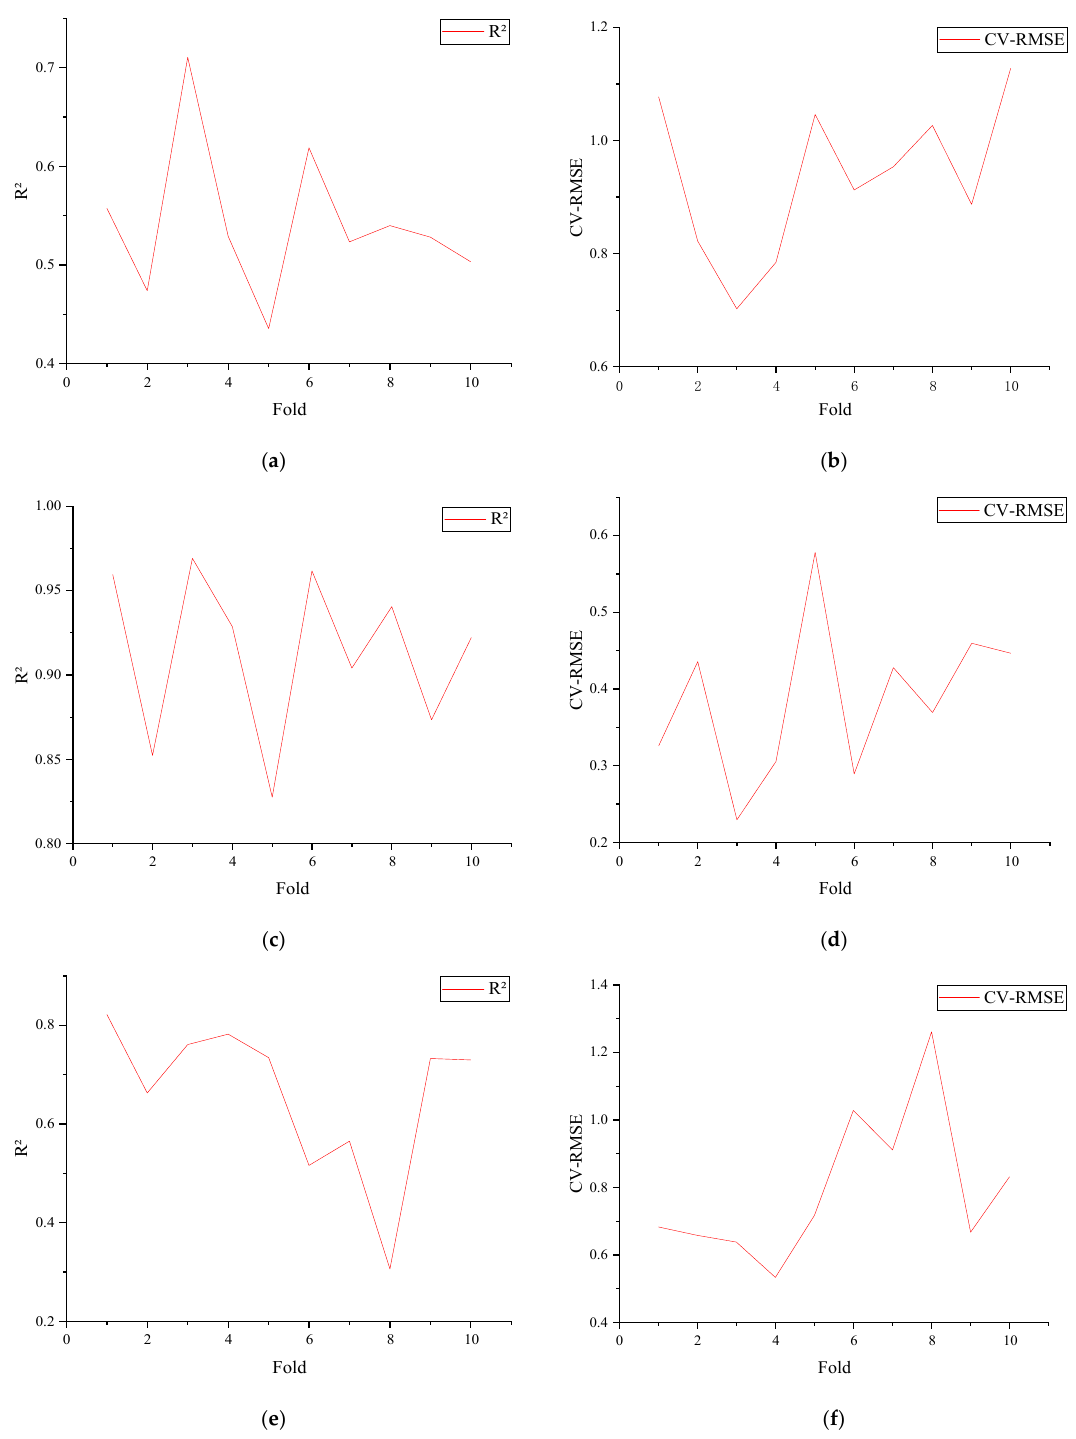
Figure 11. Accuracy index of Gaussian process regression model with ten-fold cross-validation (data processed by grid searching method). ( a ) R 2 (SVM). ( b ) CV-RMSE (SVM). ( c ) R 2 (RT). ( d ) CV-RMSE (RT). ( e ) R 2 (ANN). ( f ) CV-RMSE (ANN). The SVM model with three-fold cross-validation had the highest accuracy, with R 2 of 0.7106 and CV-RMSE of 0.7023. The regression tree model with three-fold cross-validation